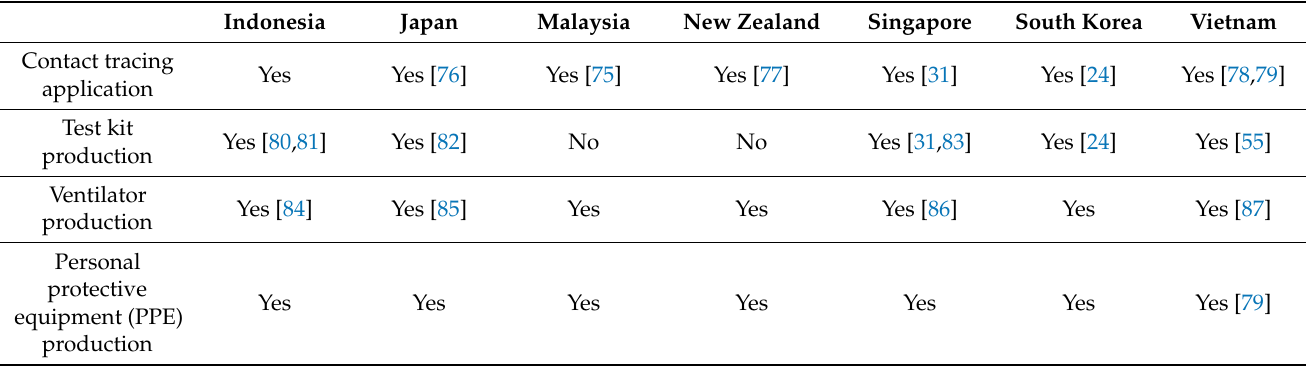
Table 9. Technology availability for COVID-19